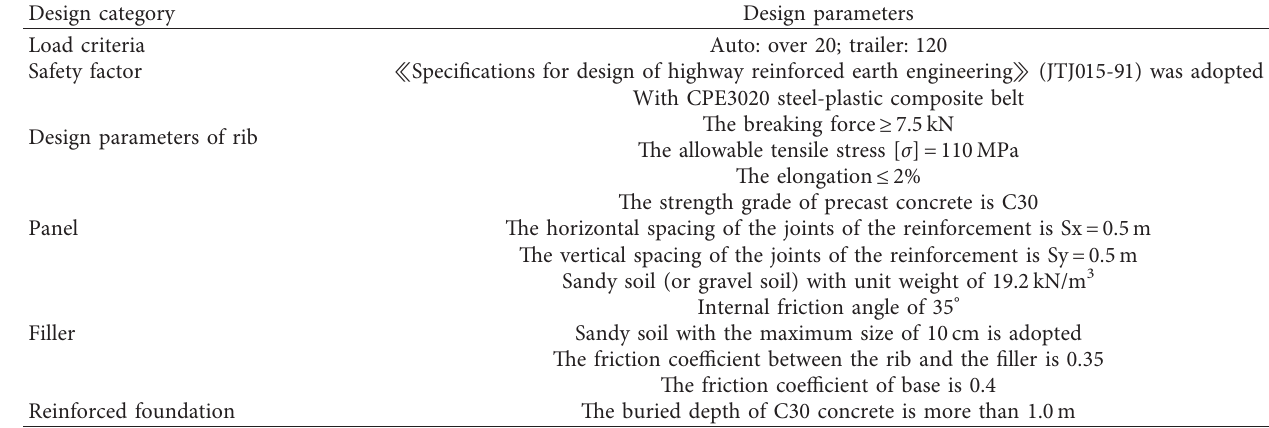
Table 2: Design parameters of the retaining wall.